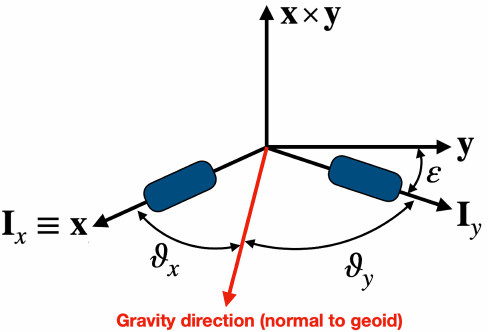
Figure 1. Geometry of the inclinometer system and associated reference